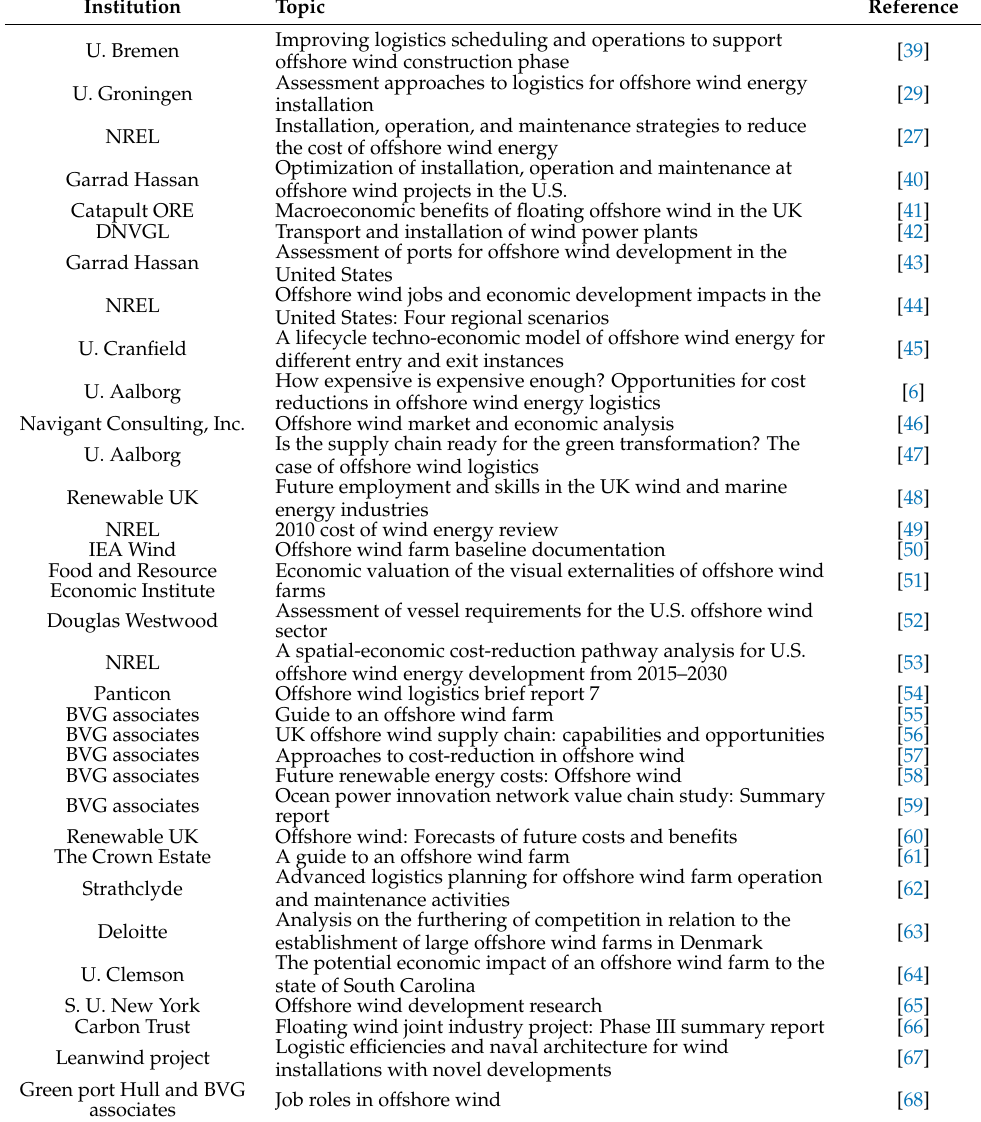
Table 1. External documentation used for the model